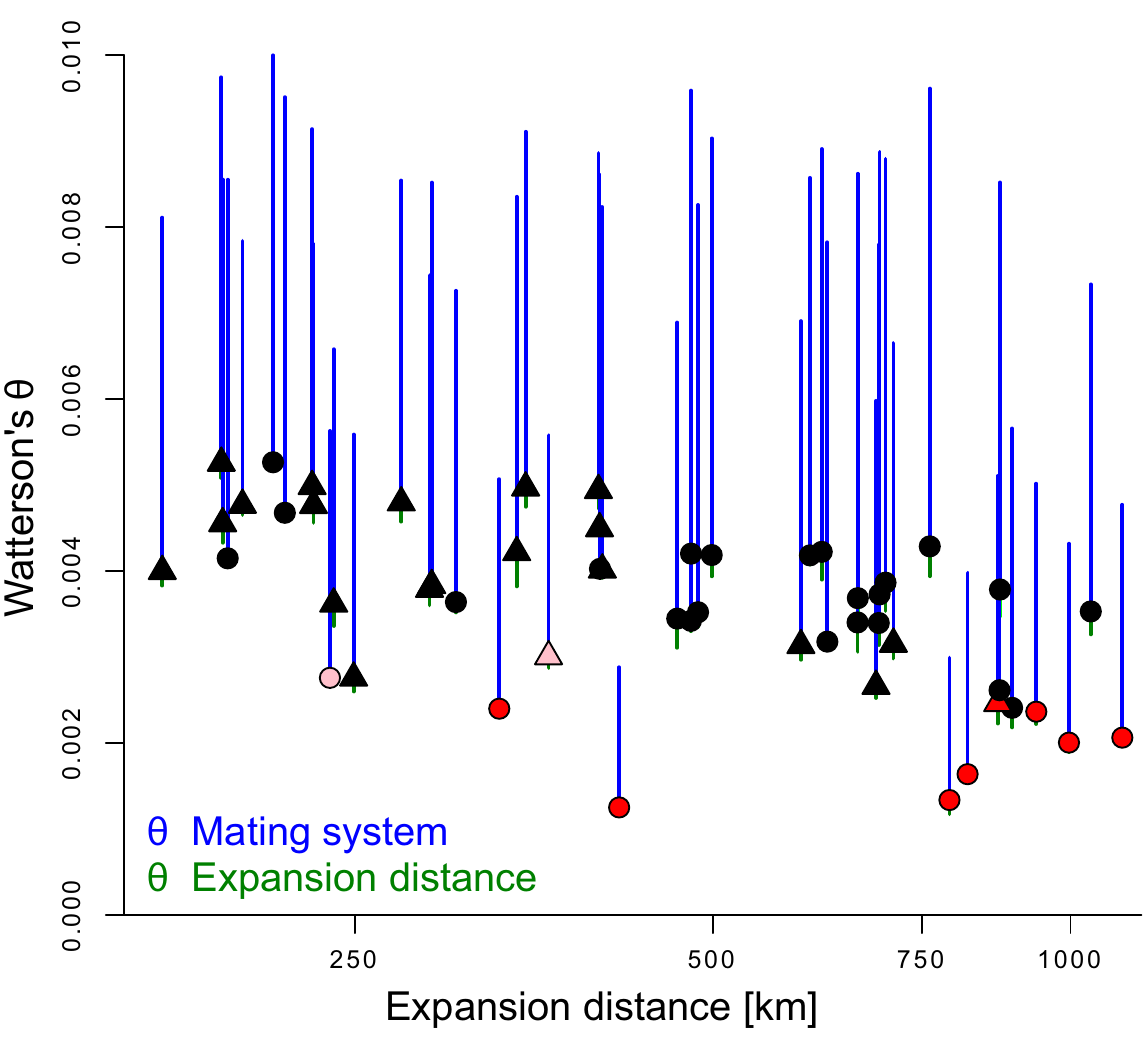
Fig 5. Watterson’s θ across all studied genic regions for each population against expansion distance (or distance from core for rear-edge populations, in log-scale). Each symbol represents the average estimate of a population. The symbol type reflects the genetic cluster (circle for west, triangle for east) and the symbol colour the mating system: outcrossing (black), mixed-mating (pink), and selfing (red). Bars depict the difference in average genetic diversity between non-outlier genes and outlier genes linked to expansion distance (green) or mating system (blue).